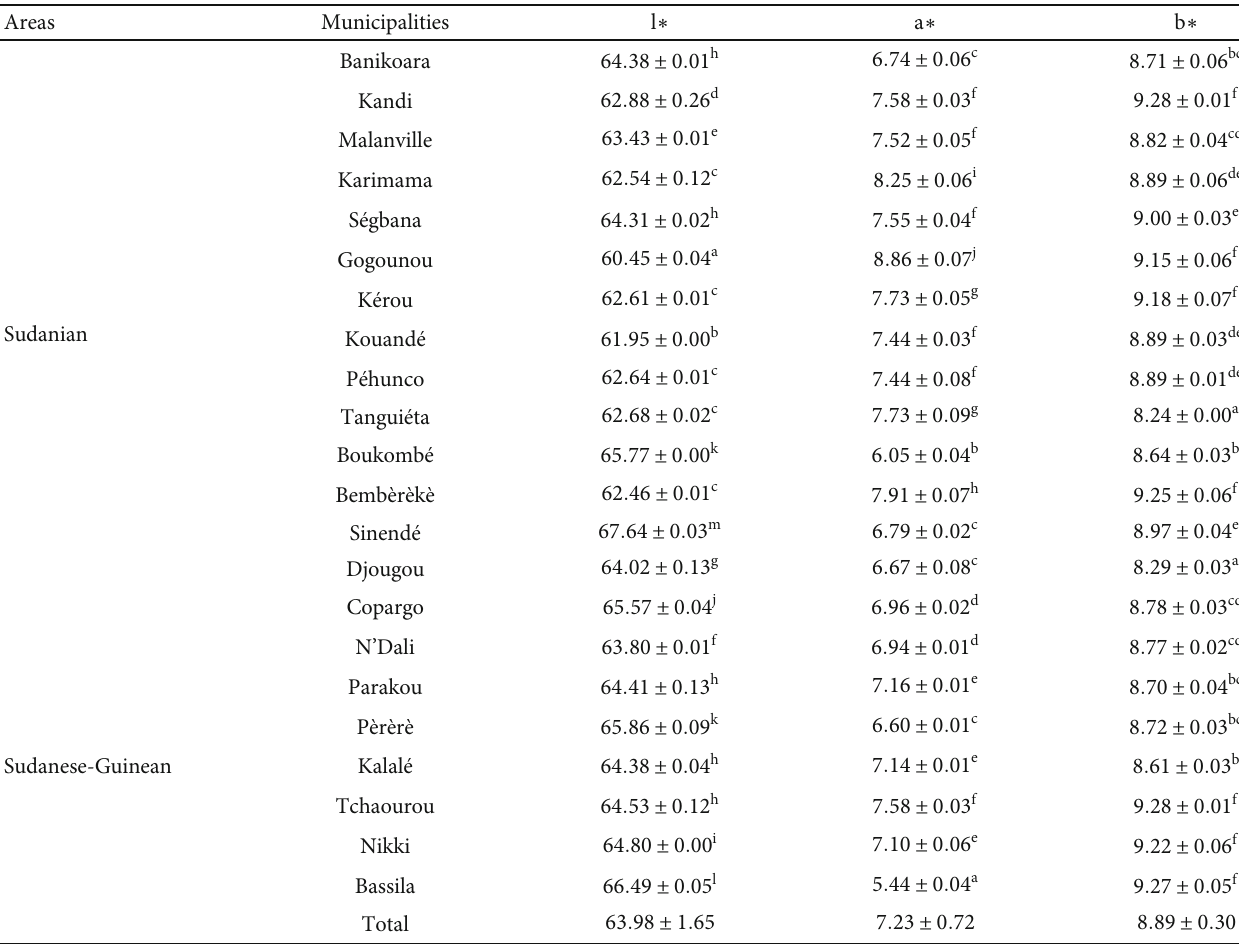
Table 2: Color parameters of Detarium microcarpum